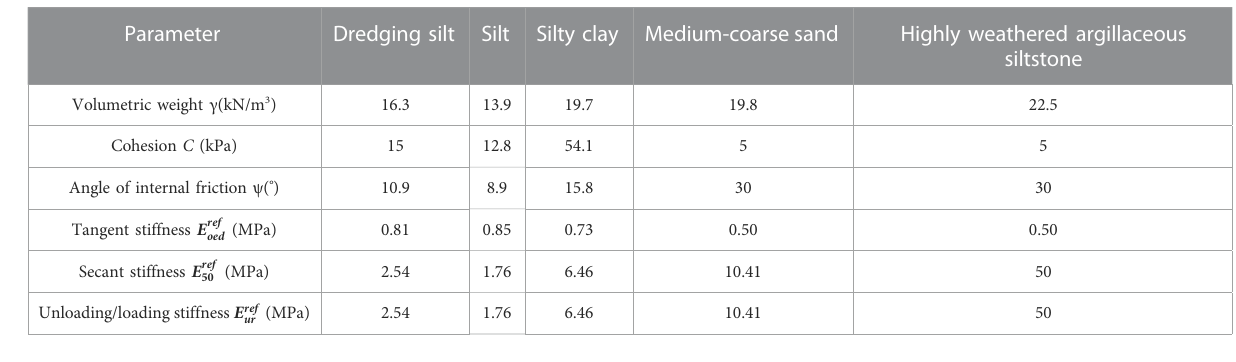
the model, and free boundary on top. As the No.9 and No.10 connecting aisles are located on the seabed, the overlying seawater is simulated by water pressure, and the